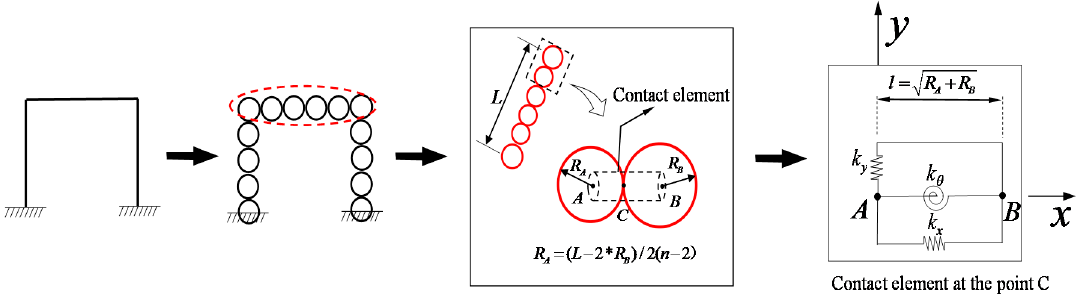
Figure 1. Discretization procedure of a plane steel frame.